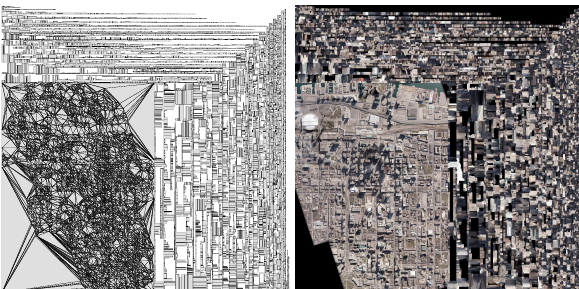
Figure 3. Automatically computed UV layout (left) and texture (right) for the Toronto dataset.